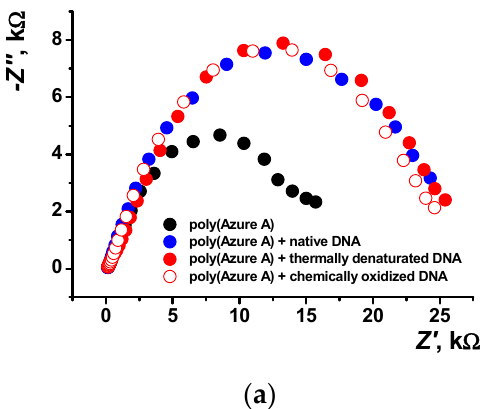
Figure 11. Nyquist diagrams of the impedance spectra recorded on the GCE covered with poly(Azure A) with and without DNA addition for the film–solution interface: ( a ) electropolymerization from aqueous solution of 0.2 mM Azure A in 0.1 M phosphate buffer containing 0.1 M NaNO 3 and 0.2 mg/mL DNA; ( b ) saturated with chloroform. Frequency range from 100 kHz to 0.04 Hz, amplitude of the applied sine potential 5 mV, pH = 7.0, and twenty cycles.